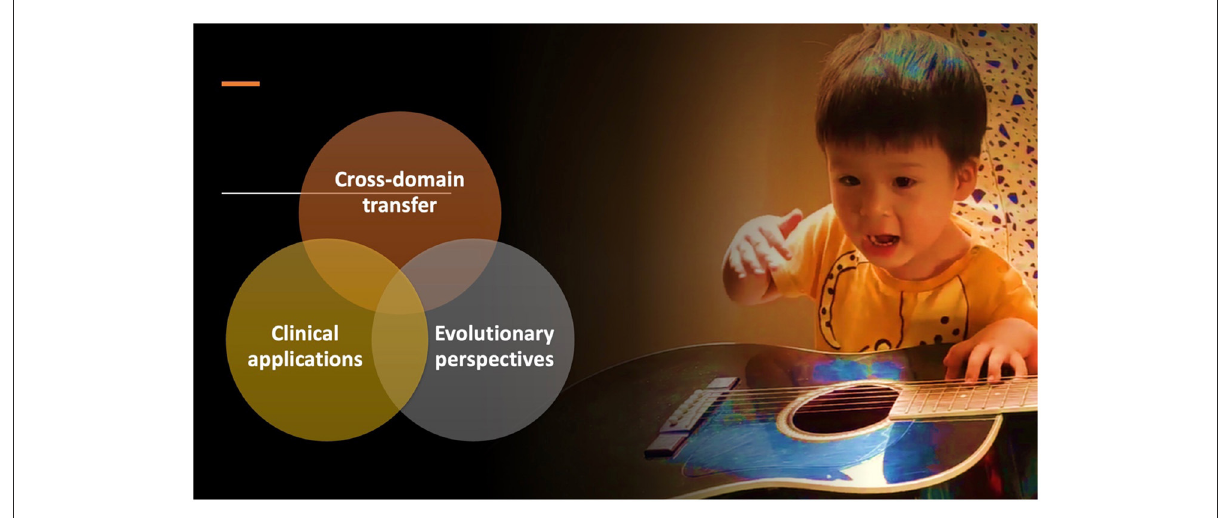
FIGURE1 Three areas of study covered by the current Research